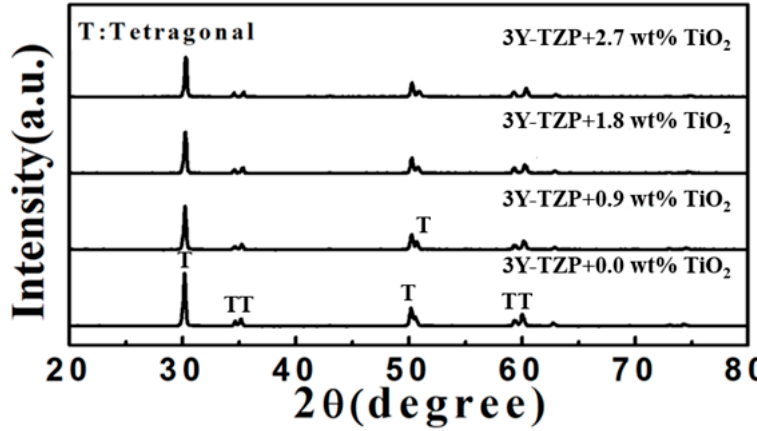
Figure 1. XRD patterns of the microwave-sintered 3 mol% yttria-stabilized zirconia (3Y-TZP) samples with the addition of 0, 0.9, 1.8, and 2.7 wt% nano TiO 2 powders.